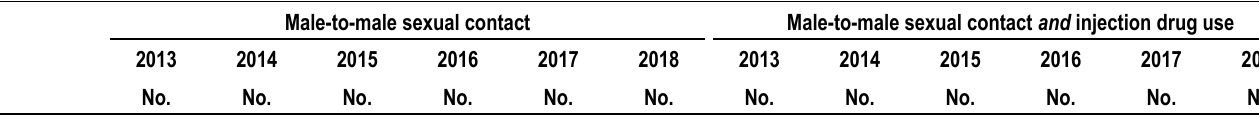
Table 10a. Stage 3 (AIDS) attributed to male-to-male sexual contact and male-to-male sexual contact and injection drug use, by